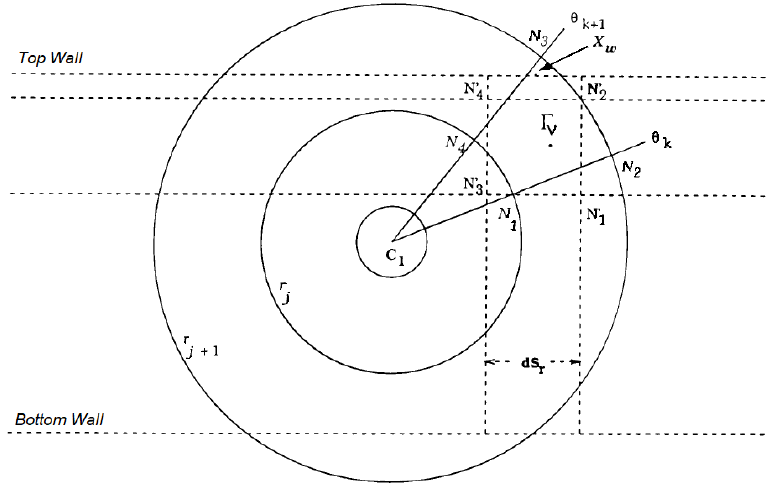
Figure 1. The overlapping grid system.